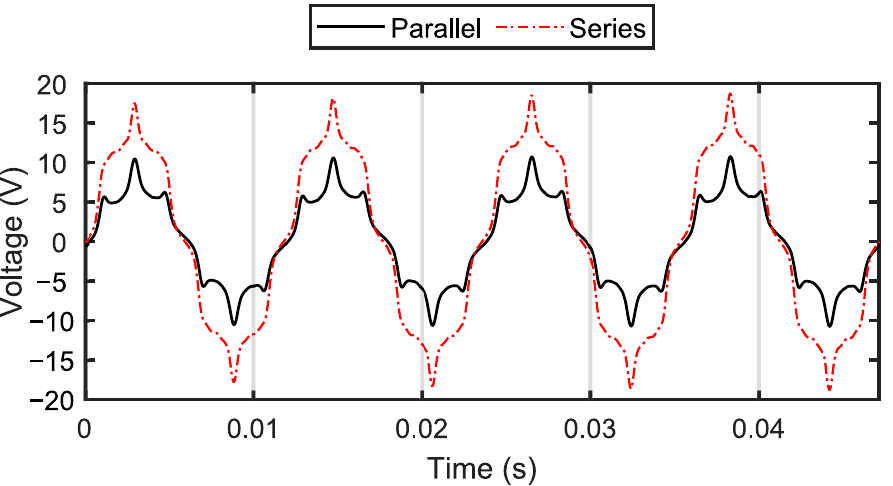
Figure 10. Induced phase voltage considering parallel and series connection of field